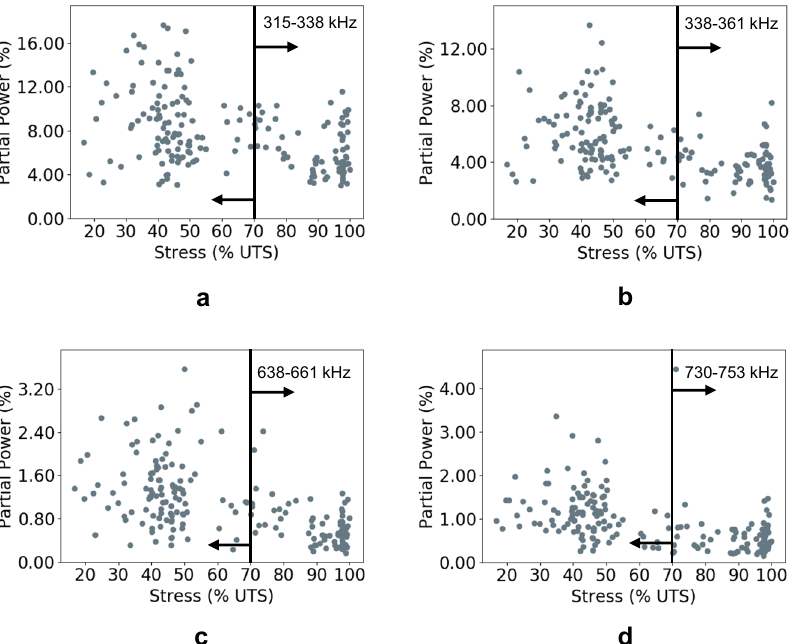
Fig. 4 Partial power as a function of stress for four selected frequency bands in Specimen 3. Events occurring below 70% UTS are sampled from a different distribution than events occurring >70% UTS at a signi fi cance level of α = 0.01 in frequency bands ( a ) 315-338 kHz, ( b ) 338- 361 kHz, ( c ) 638-661 kHz, and ( d ) 730-753 kHz. This is not predicted by the orthotropic model of wave propagation. We hypothesize that the shift in partial power is a result of a shift in active damage mechanism from matrix cracking to fi ber failure; however, further experimentation and modeling is